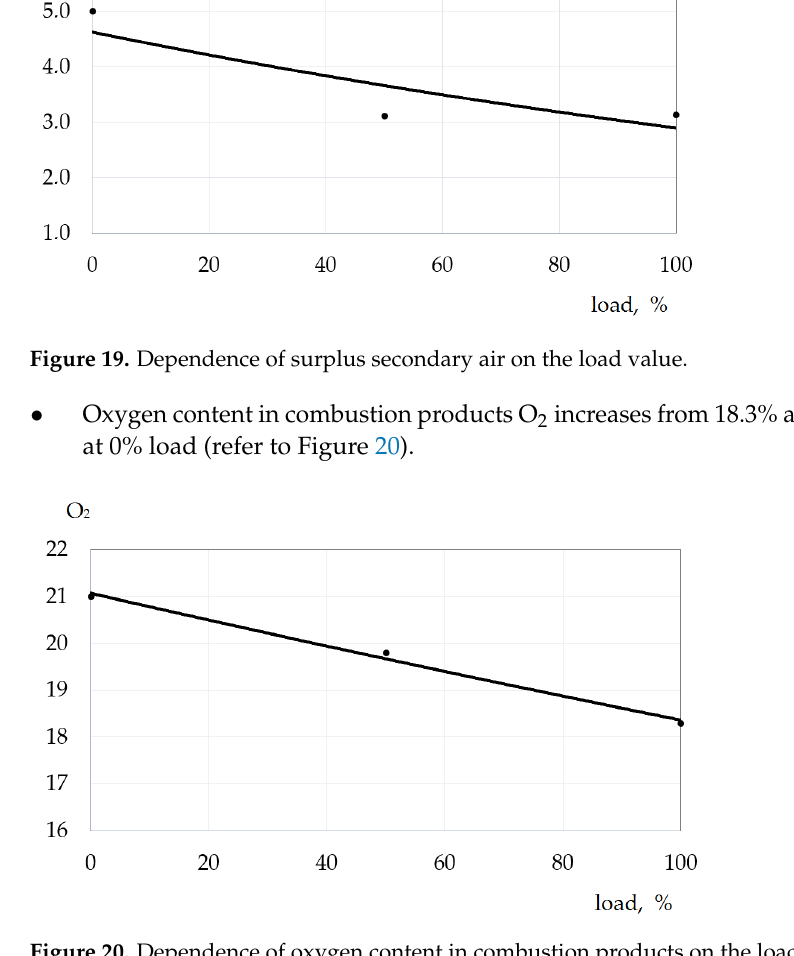
Figure 20. Dependence of oxygen content in combustion products on the load value.